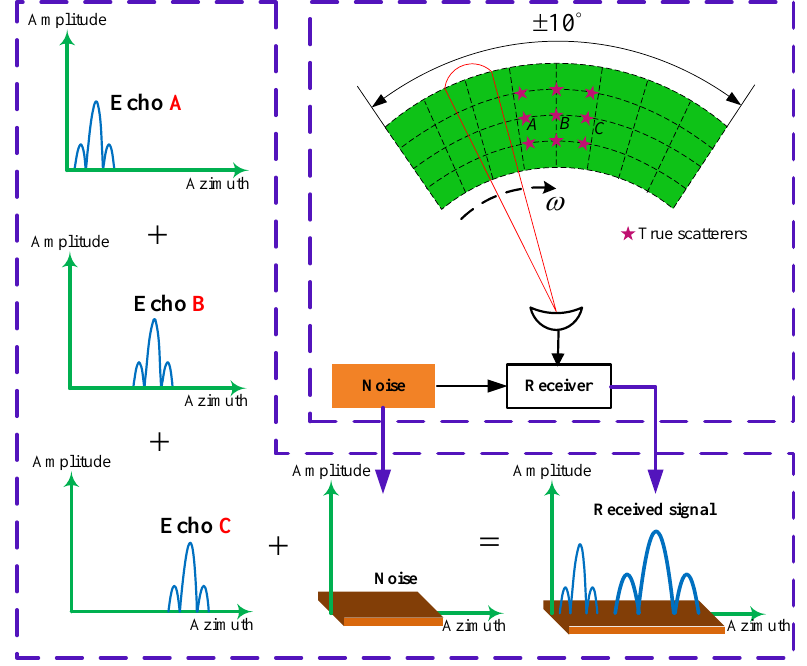
Figure 2. The diagram of signal model of forward looking